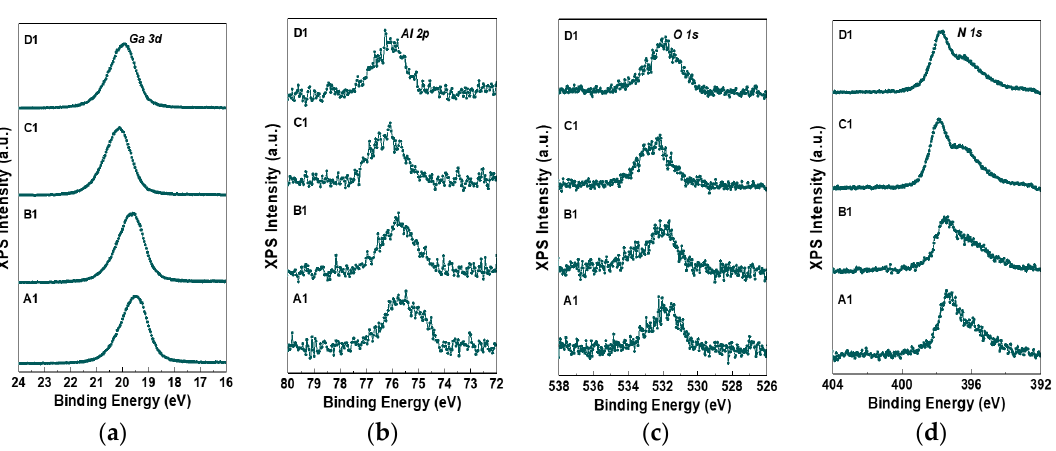
Figure 2. XPS spectra of ( a ) Ga 3d, ( b ) Al 2p, ( c ) O 1s, and ( d ) N 1s core levels at 1nm Al 2 O 3 /GaN interfaces with post-deposition annealing (PDA) conditions: no anneal (A1), 500 °C for 3 min (B1), 700 °C for 3 min (C1), and 900 °C for 3 min (D1).